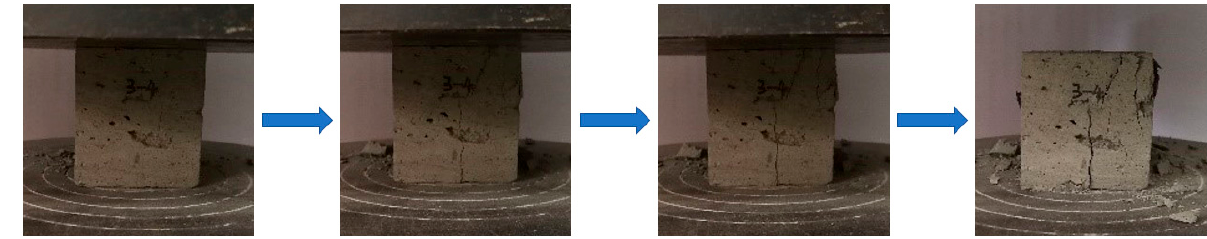
Figure 5. Change in the appearance of gray brick specimen during uniaxial